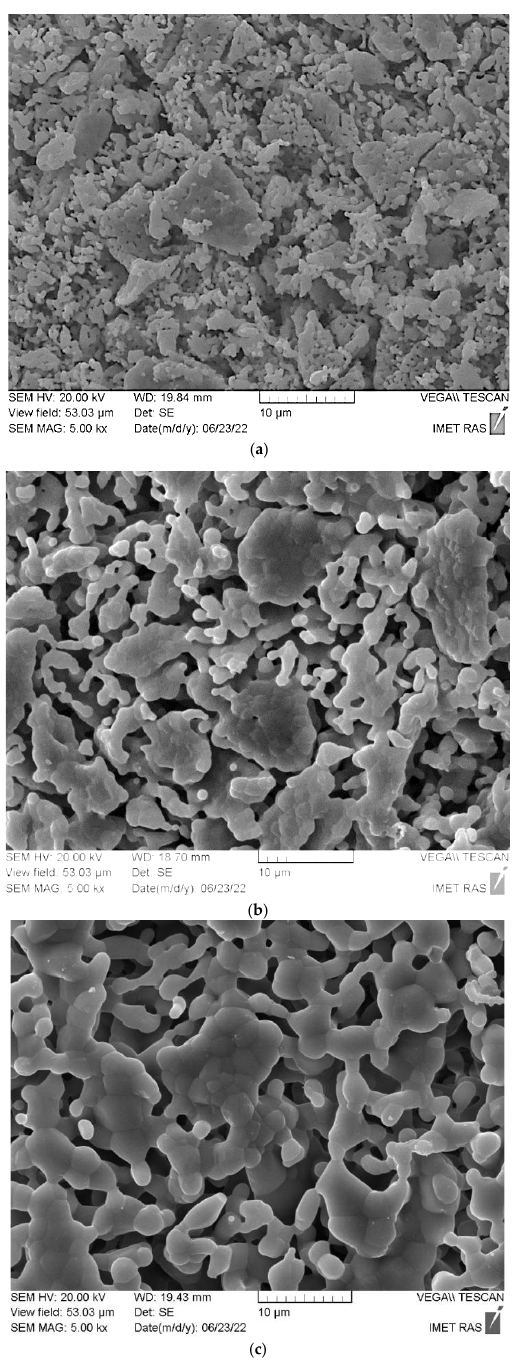
Figure 8. SEM images of ceramic samples prepared from the powder mixture of synthesized dical- cium hydrogen phosphates (mainly brushite CaHPO 4 ‧ 2H 2 O) and calcium citrate